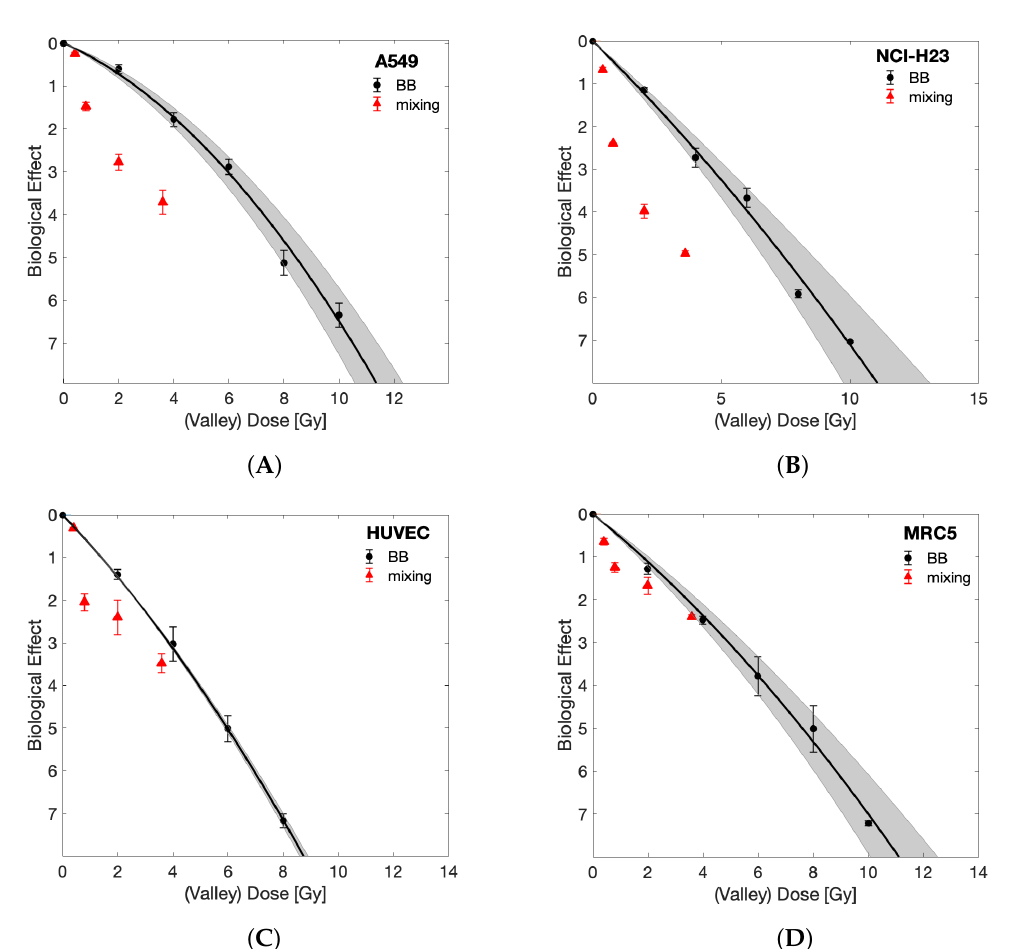
Figure 5. Comparing the biological effect of BB against the valley dose of dose mixing experiment. Dose mixing surviving fractions were divided by 0.8 to account for only 80% of cells receiving the valley dose. BB results are shown with the relevant LQ-model fit (shaded areas indicate 95% confidence intervals). Survival curves are shown for tumour ( A ) A549, ( B ) NCI-H23 and normal ( C ) HUVEC and ( D ) MRC-5 cell